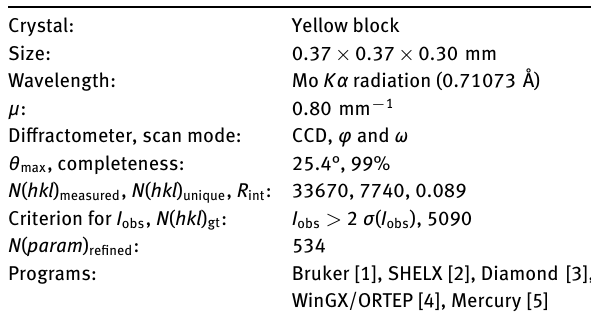
Table 1: Data collection and handling.